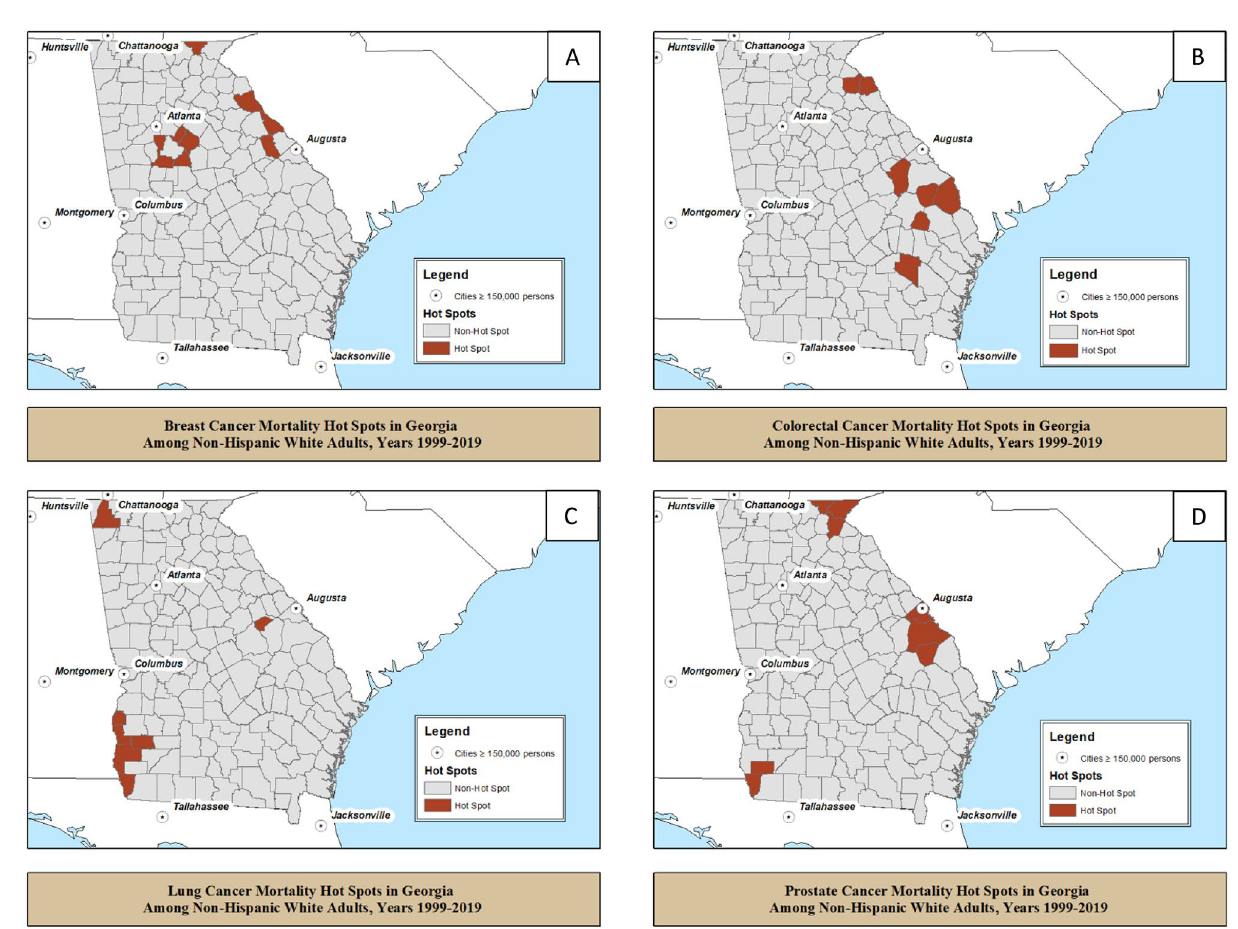
Figure 2. Hot spots of cancer mortality stratified by major cancer types: breast, colorectal, lung, and prostate among non-Hispanic white adults in Georgia counties from years 1999 through